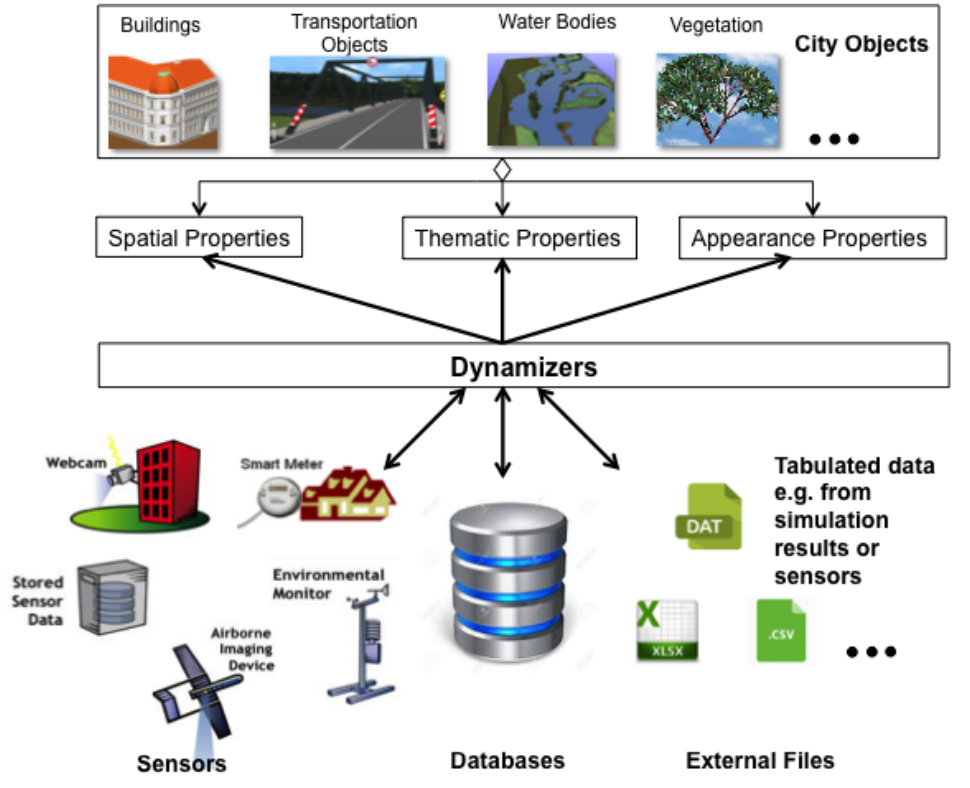
Figure 3. Conceptual representation of Dynamizers, allowing (i) the representation of time-variant values from sensors, simulation specific databases, and external files, (ii) enhancing the properties of city objects by overriding their static